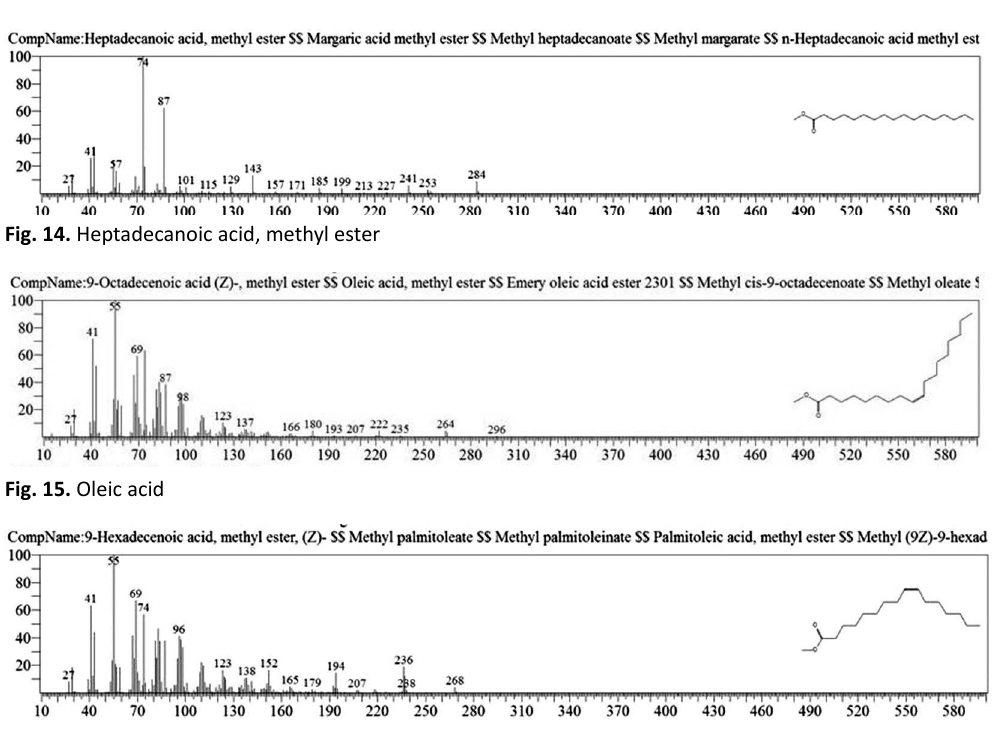
Fig. 16. 9- Hexadecenoic acid, methyl